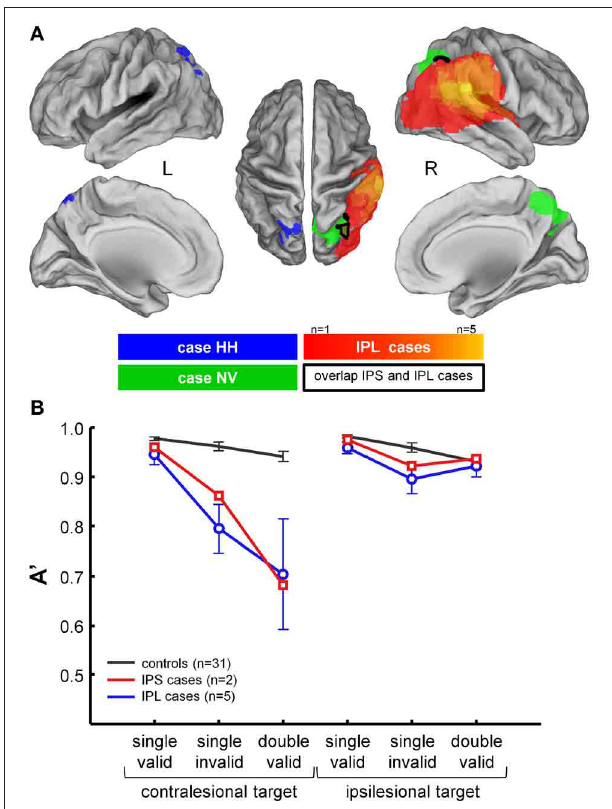
FIGURE 5 | Comparison between performance in NV and HH during the hybrid spatial cueing paradigm and five cases with classical lesions of right IPL due to ischemia of the territory of the posterior branch of the middle cerebral artery. (A) Projection of the lesion in HH (blue), NV (green), and the IPL cases (hot scale). (B) Average performance in HH and NV (red), in the IPL cases (blue), and in controls (black). For further details see Gillebert et al.